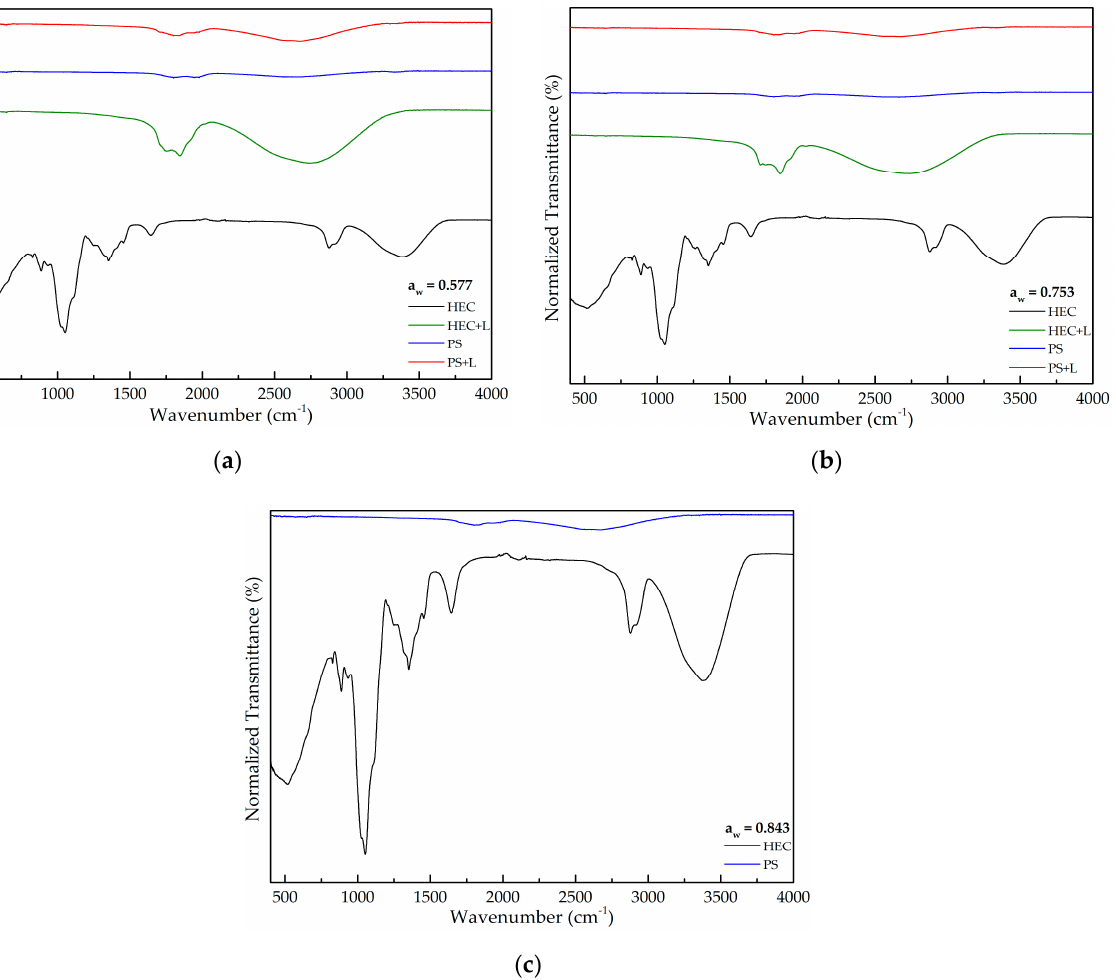
Figure 5. FTIR spectra for HEC and PS films exposed to ( a ) 0.577; ( b ) 0.753; ( c ) 0.843 a w